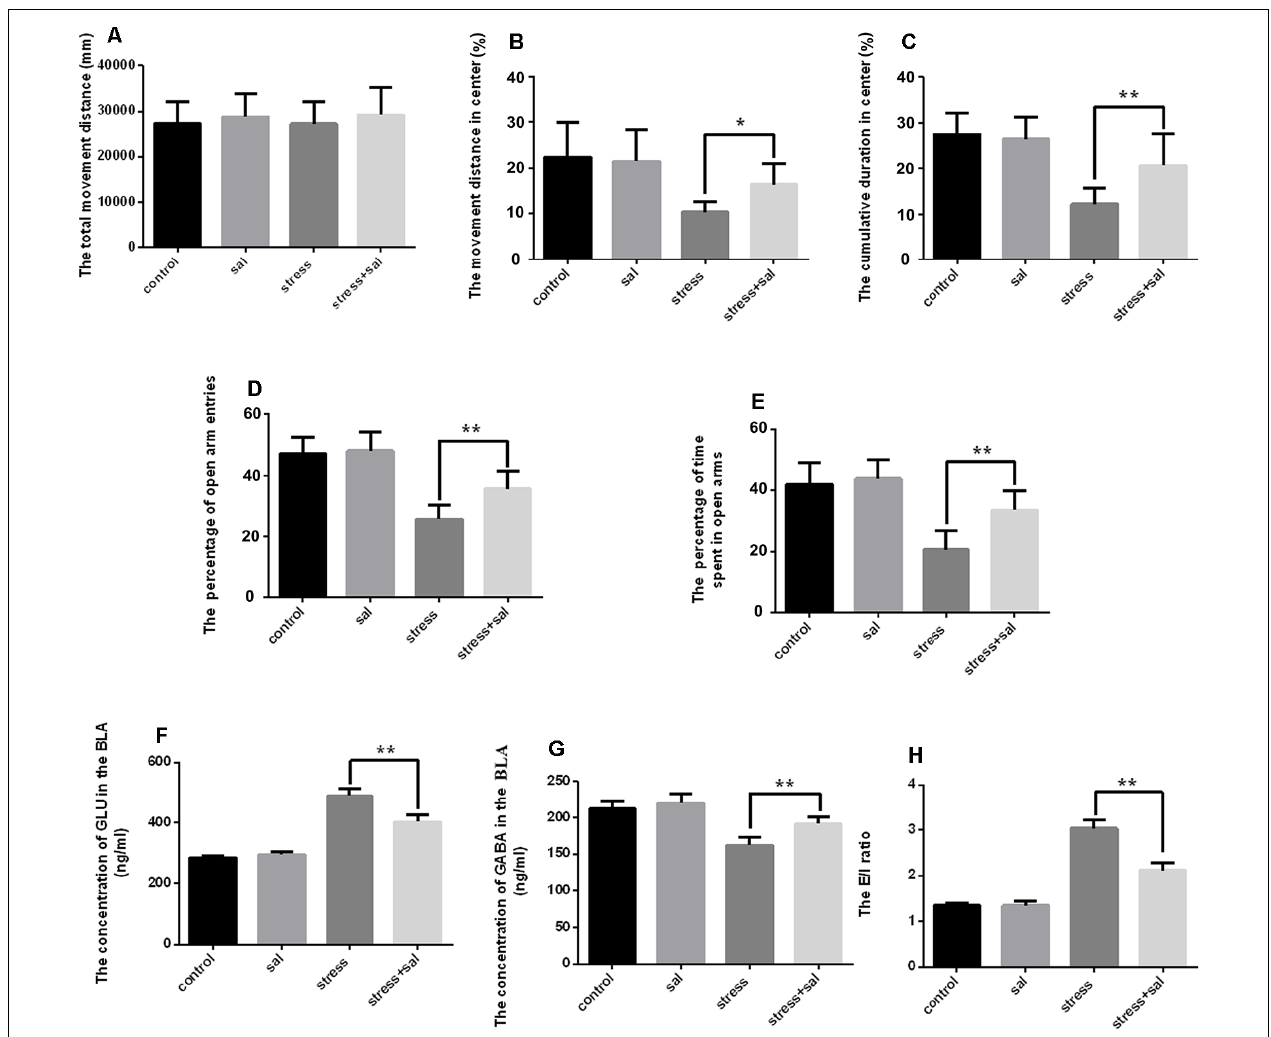
FIGURE 4 | Inhibition of the PERK pathway counteracts anxiety and neurotransmitter changes in the amygdala of rats. (A) Total movement distance on the open field test. (B) Percentage of movement distance in the center area of the open field test. (C) Percentage of cumulative duration in the center area of the open field test. (D) Percentage of open arm entries on the EPM. (E) Percentage of time spent in open arms of the EPM. (F) The concentration of GLU in the amygdala. (G) The concentration of GABA in the amygdala. (H) The excitation/inhibition (E/I) ratio. Data (mean ± SEM) represent. ∗ P < 0.05, ∗∗ P < 0.01 vs. stress group ( n =